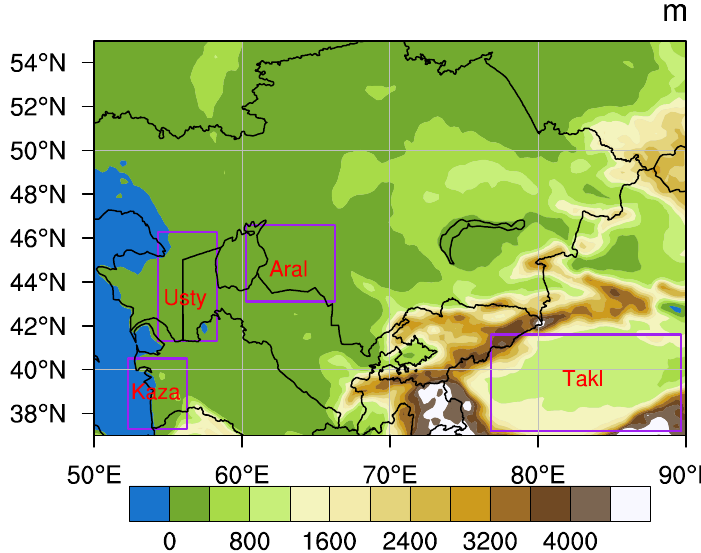
Figure 1. The research domain, Central Asia and its topography (shading area, unit: m). Purple boxes represent four sub-regions where statistical analysis was applied. We use Kaza to refer to the area surrounding Kazandzhik and use Usty, Aral, and Takl to refer to the Ustyurt Plateau, the Aral Kum Desert, and the Taklimakan Desert, respectively.